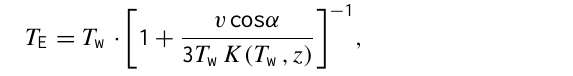
0 for north- = 0 for head seas, in- =